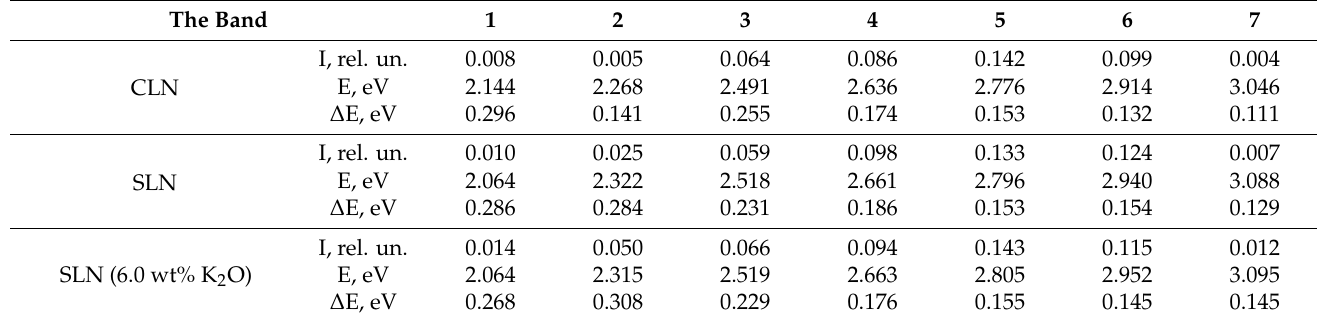
Table 2. Spectral characteristics of separated surface luminescence bands of the studied